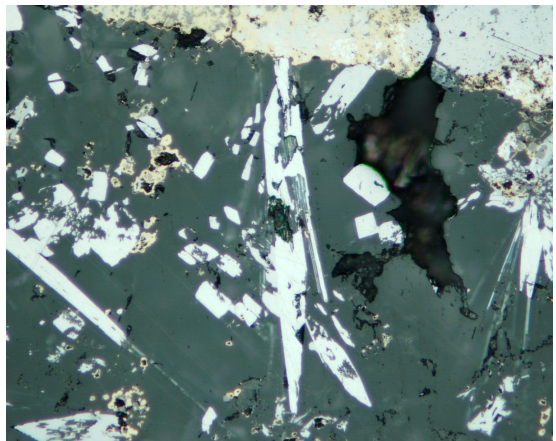
Figure 4. Antimonselite prismatic crystals and their rhombic sections in association with yellow chalcopyrite and grey tetrahedrite. Reflected light, one polarizer. Field of view 210 μ m. P ř íbram, a dump of the shaft 16. Photo by P. Škácha.